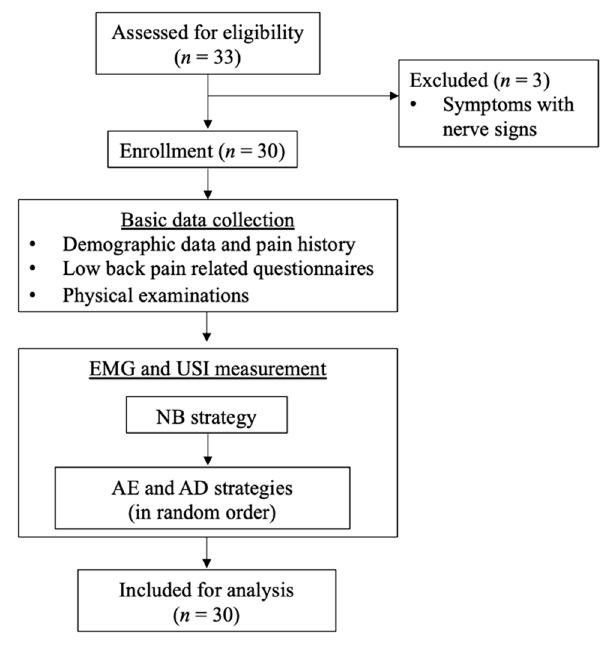
Figure 1. Flowchart of participant recruitment and data collection. EMG: electromyography; USI: ultrasound imaging; NB: natural breathing; AD: abdominal drawing-in; AE: abdominal expansion. The inclusion criteria were as follows: (1) age between 20 and 50 years; (2) unilateral or bilateral pain between the 12th thoracic vertebra and the gluteal line; (3) current pain intensity ≥ 2 as per the numeric rating scale The exclusion criteria were as follows: (1) current neurological symptoms or signs related to the back; (2) specific back-related conditions (e.g., spinal deformities, fractures or surgery); (3) presence of abdominal, cardiopulmonary, or gastrointestinal conditions that interfere with daily living within the past 6 months; (4) urinary conditions; (5) medical conditions that affect balance (e.g., stroke, vestibular disorders, and cancer); (6) current participation in structured and supervised core or trunk exercise training programs; (7) body mass index of >30 kg/m 2 [22]; and (8)